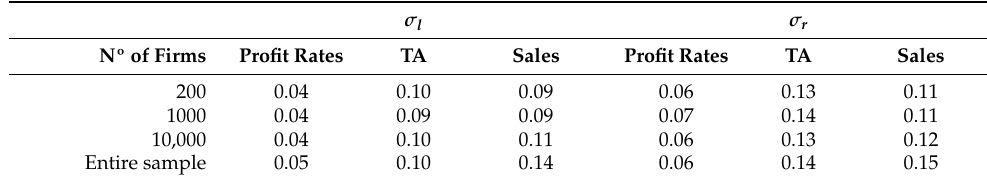
Table 6. Median of the estimates σ l and σ r reported in Figures 9–11.